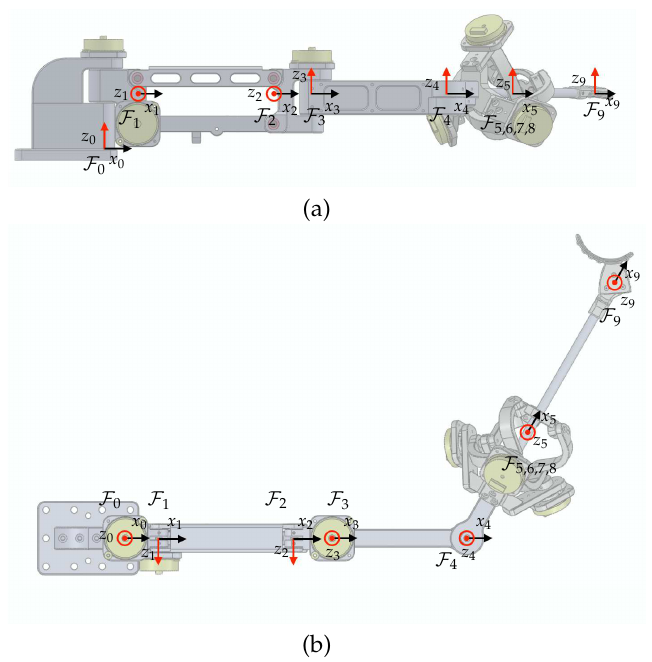
Figure 8. The frame assignments for the proposed link structure: ( a ) front view; ( b ) top view. Table 2. Denavit–Hartenberg parameters for